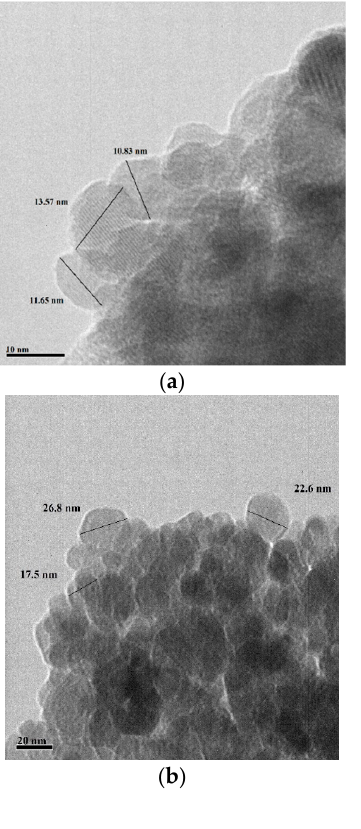
Figure 1. The FTIR spectra of ( a ) poly vinyl acetate (PVA), gelatin (gel), ( b ) Super-paramagnetic iron oxide nanoparticles (SPIONs), SPIONs/gel and SPIONs/gel/PVA. The TEM images of SPIONs (a), SPIONs/gel (b), and SPIONs/gel/PVA (c) are shown in Figure 2. The TEM images showed that SPIONs, SPIONs/gel, and SPIONs/gel/PVA particles are quasi-spherical in shape with rough surfaces. The sizes of SPIONs, SPIONs/gel, and SPIONs/gel/PVA were measured to be approximately 14.02 nm, 22.63 nm, and 18.6 nm, respectively, from their TEM images. Furthermore, the DLS measurement showed the sizes of SPIONs, SPIONs/gel, and SPIONs/gel/PVA were with 15.2 nm, 22.47 nm, and 17.74 nm, respectively. The size of the magnetic nanoparticles results from TEM and DLS were identical.